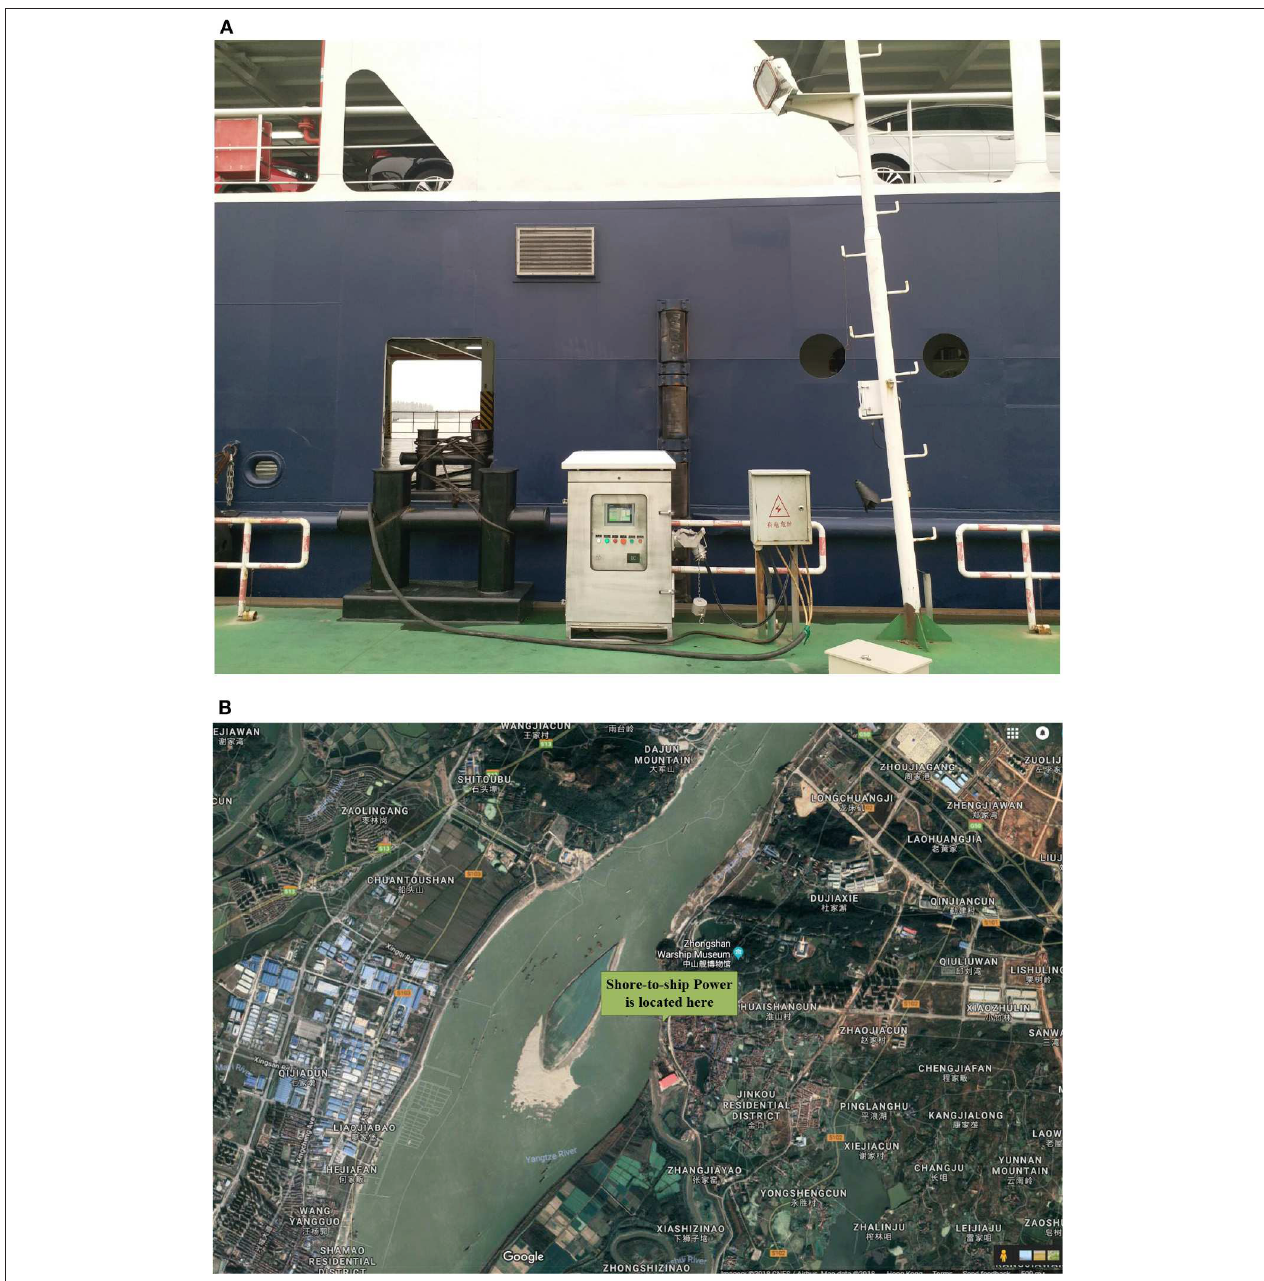
FIGURE 3 | Shore-to-ship power charging piles (Yangtze River Shipping Industry Research Center) and a map of their location beside the Yangtze River. (A) Shore-to-ship power charging piles set up by the Yangtze River Shipping Industry Research Center with no cable lifting device and connection system. (B) The shore-to-ship power charging pile was located in Jinkou Ro-Ro Terminal beside the Yangtze River, Wuhan city.